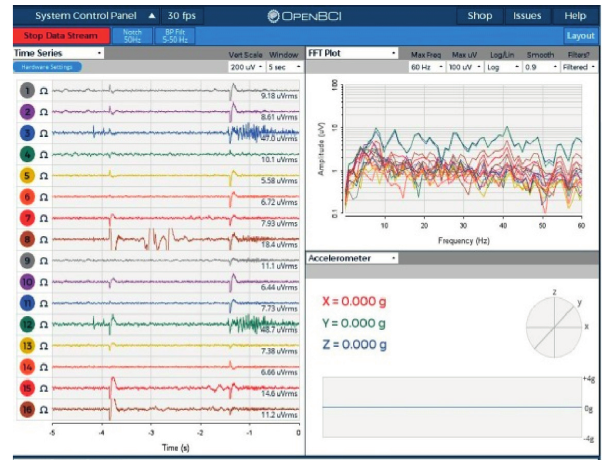
Figure 10: The EEG of knock action idea in the static state.